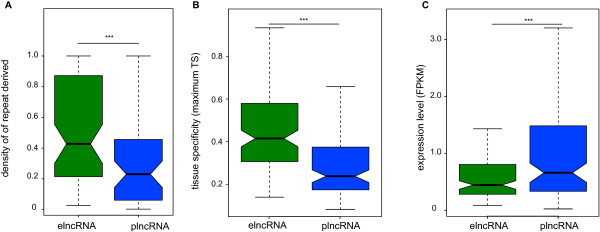
elncRNA and plncRNA loci tend to show different origins and are associated with different transcriptional properties. (A) Density of transposable element (TS)-derived sequence in elncRNA (green) and plncRNA (blue) exons. (B) elncRNAs (median (elncRNAmaxTS) = 0.41) tend to be more tissue-specific (two-tailed Mann–Whitney test, P < 5 × 10-11) than are plnRNAs (median (plncRNAmaxTS) = 0.22). (C) elncRNAs (median FPKM, (elncRNAexp) = 0.43) tend to be more lowly expressed in erythroblasts than are plncRNAs (median FPKM, (plncRNAexp) = 0.64, two-tailed Mann–Whitney test, P < 0.001). ***P < 0.001. FPKM, fragments per kilobase of sequence per million reads.